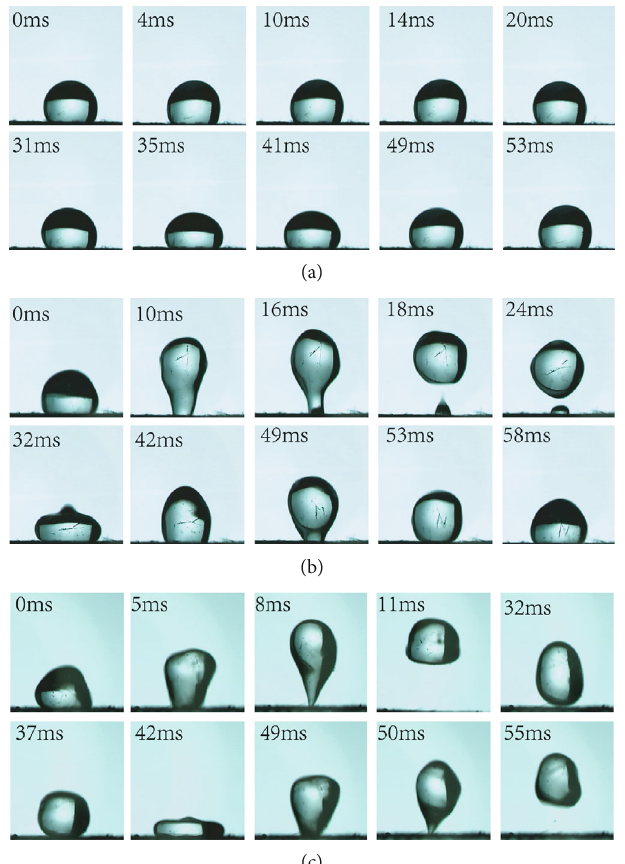
Figure 4: Under the vertical vibration frequency of 20Hz, di ff erent amplitude conditions, the movement of droplets on the surface of